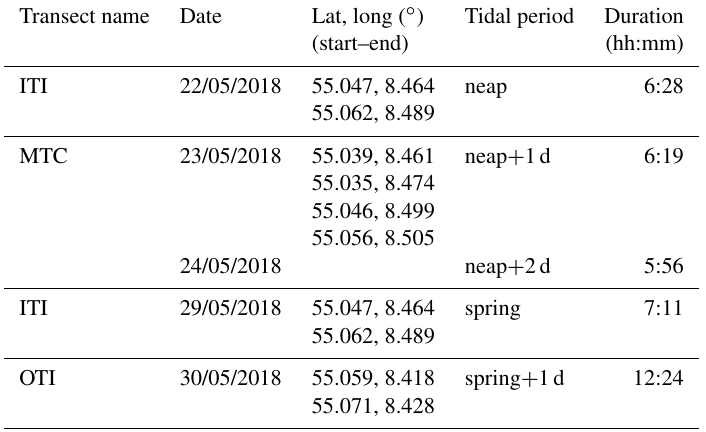
Table 1. The summary of the five cruises on board RV Mya II profiling three main transects: the inner tidal inlet (ITI), the main tidal channels (MTC) and the outer tidal inlet